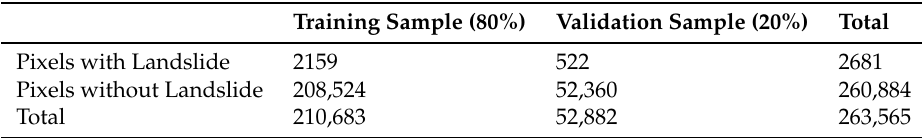
Table 2. Number of pixel cell samples for the study